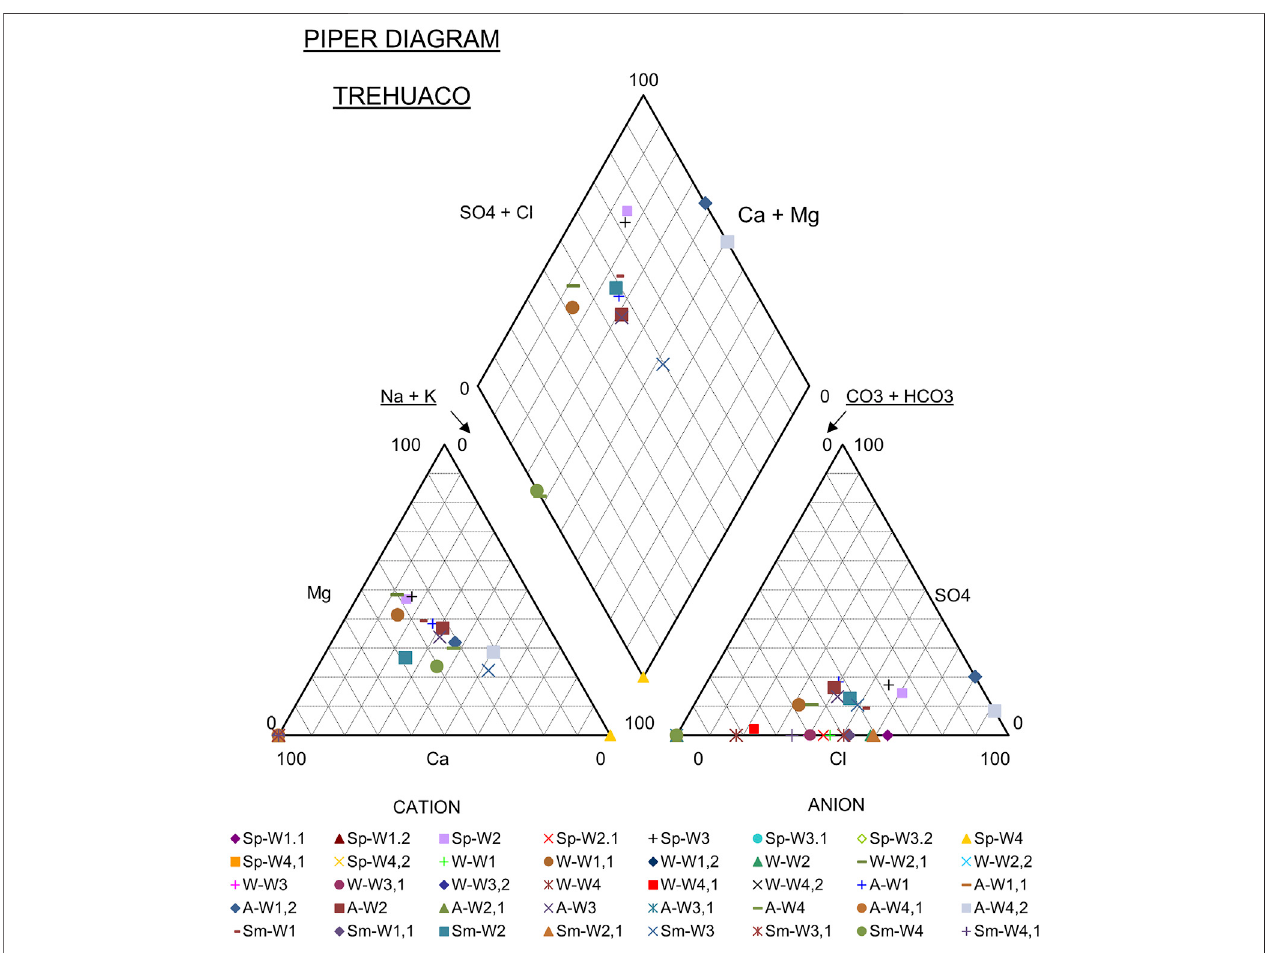
FIGURE 2 | Hydrochemistry from the community-based water monitoring through a Piper Diagram.